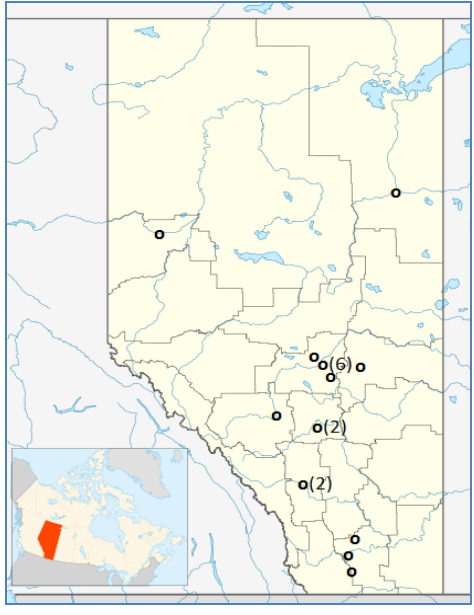
Figure 3. Participant distribution across the province of Alberta. From The Ability to Access Post- Secondary Education: Adult Learners’ Conceptions of Choosing Online Learning (p. 84), by K. Rasmussen, 2015, Lancaster University, UK. Copyright 2015 by Kari